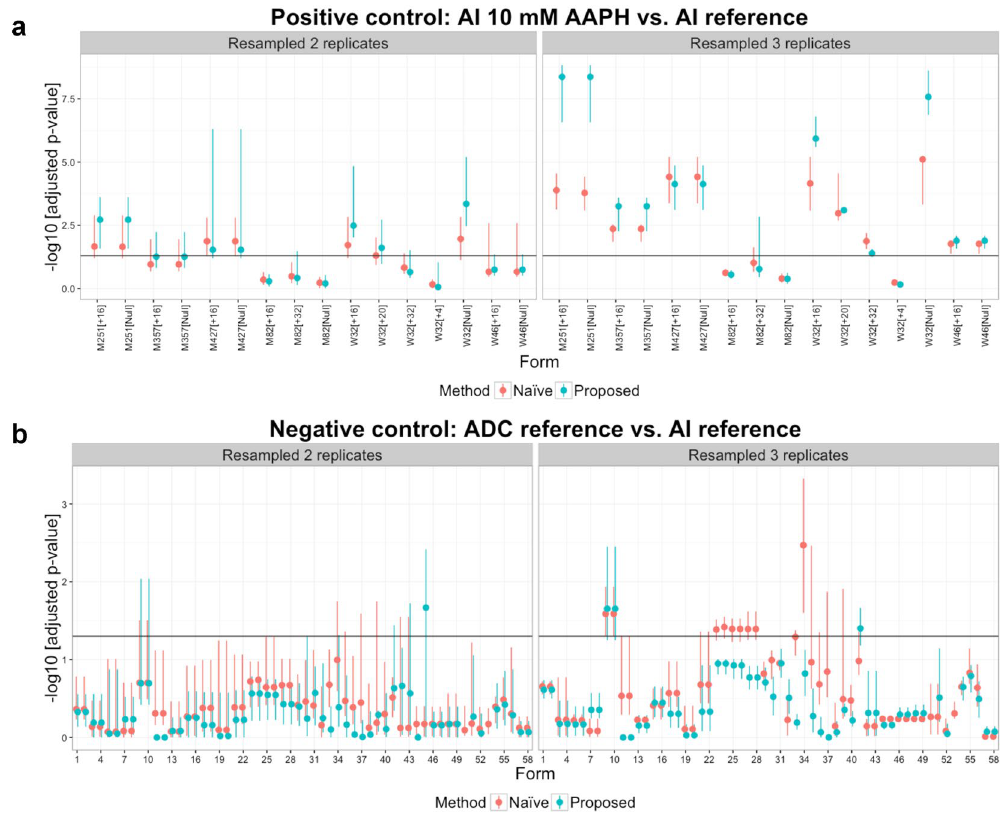
Figure 7. Differential analysis with small sample sizes. The replicate LC-MS/MS runs of the AI 10 mM AAPH, AI reference and ADC reference samples were resampled to a size of 2 or 3 per condition (without replacement) prior to the differential analysis based on H 0(1) . X-axis: compared forms. Y-axis: statistical significance, FDR- adjusted p -values on the negative log10 scale. The horizontal lines indicate the 0.05 FDR cutoff. For each form, the vertical line represents the range between the maximum and minimum significance values among the testing results for the resampled data, and the dot represents the medium value. ( a ) The results for the positive controls (AI 10 mM AAPH versus AI reference). ( b ) The results for the negative controls (ADC reference versus AI reference). The list of compared forms for the negative controls is shown in Supplementary Table